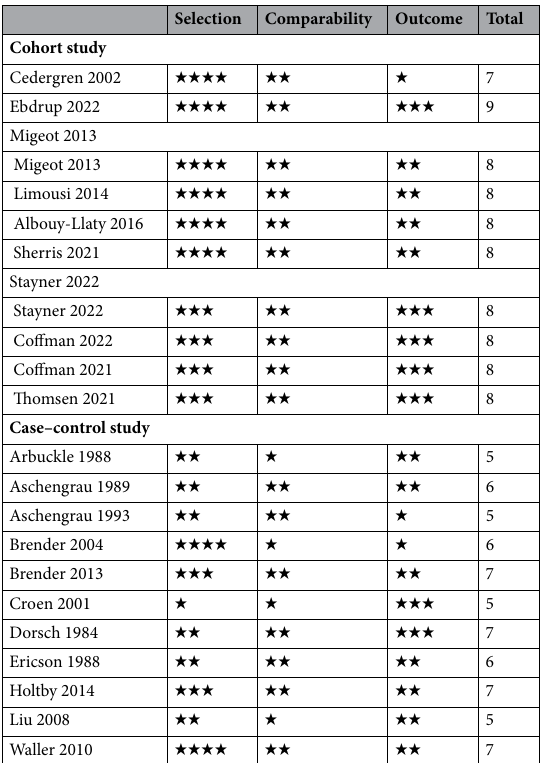
Table 2. Quality of the included studies using the Newcastle–Ottawa scale. Scale is from 0–9, where values ≥ 7 are compatible with good study